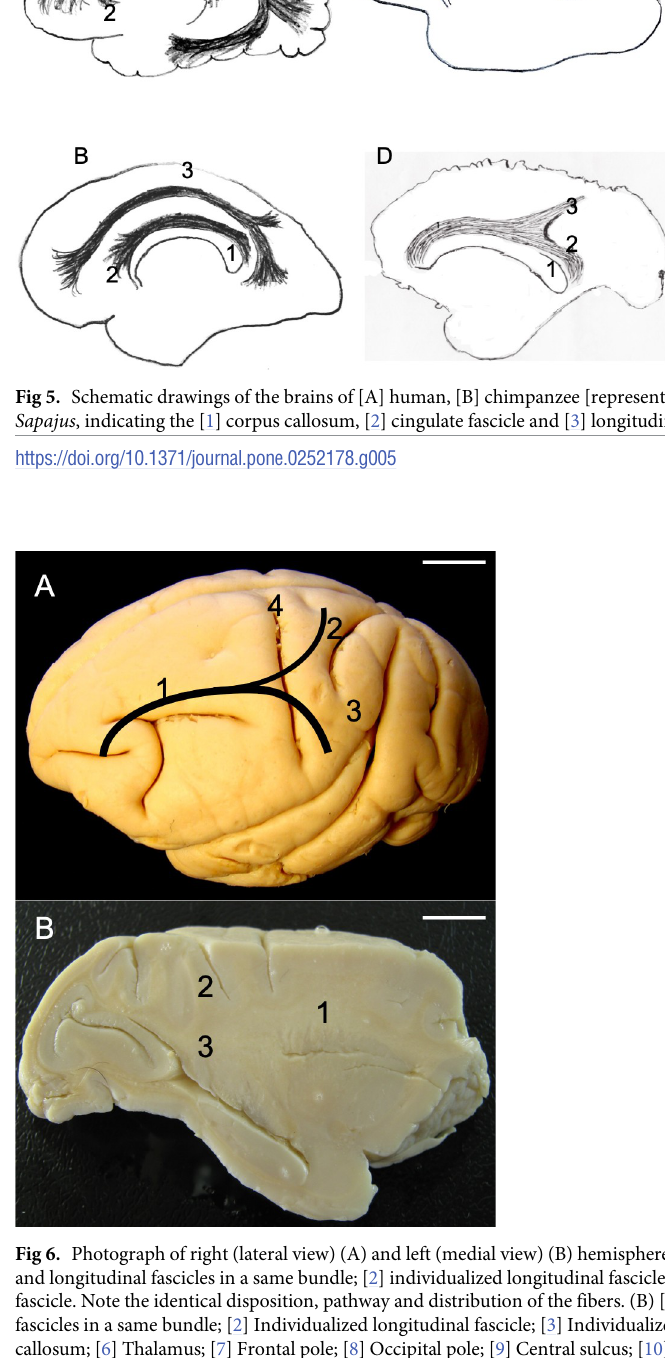
PLOS ONE | https://doi.org/10.1371/journal.pone.0252178 June 24,